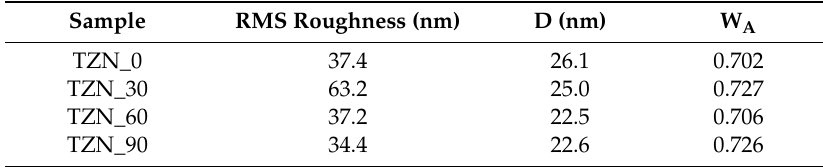
Table 1. The weight percentage of the anatase phase, the grain size and the root mean square roughness values of the investigated samples.